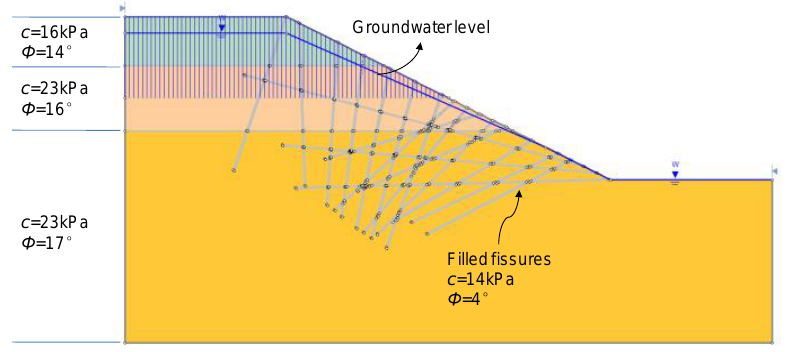
Figure 10. The calculation model of the slope.